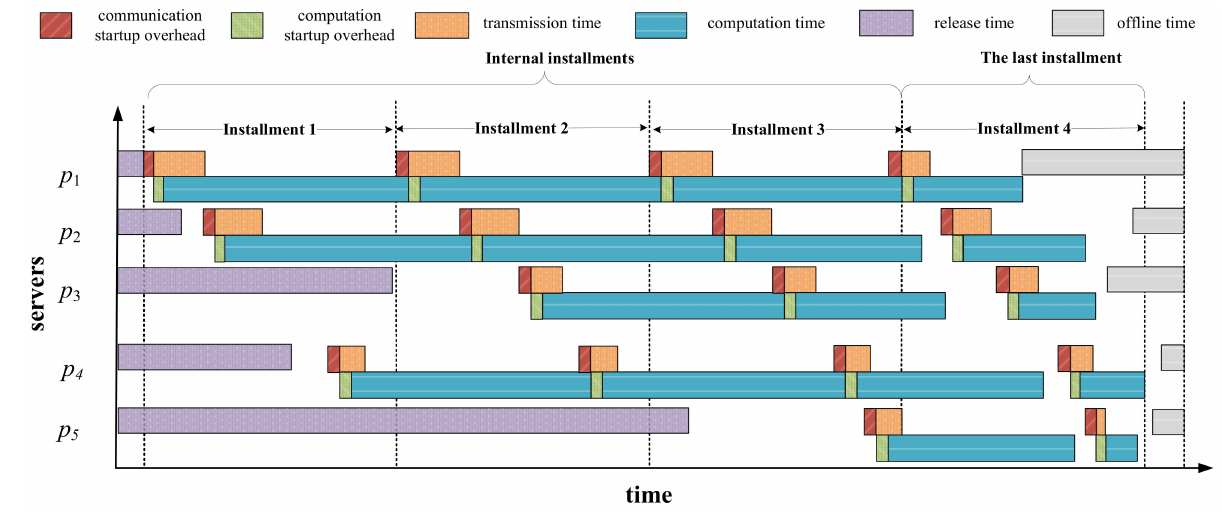
Figure 5. An example of the case when early < later